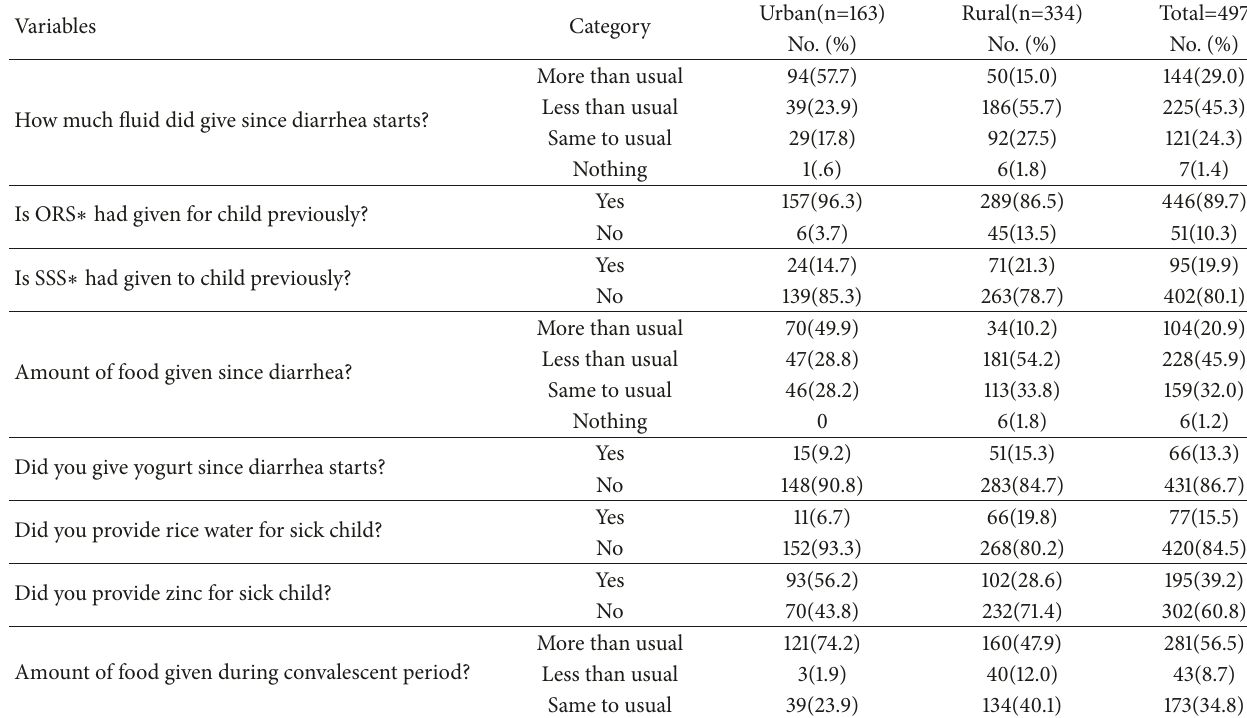
Table 5: Home management practice of diarrhea among caregivers of under-five children’s in urban and rural resident of Doba woreda,